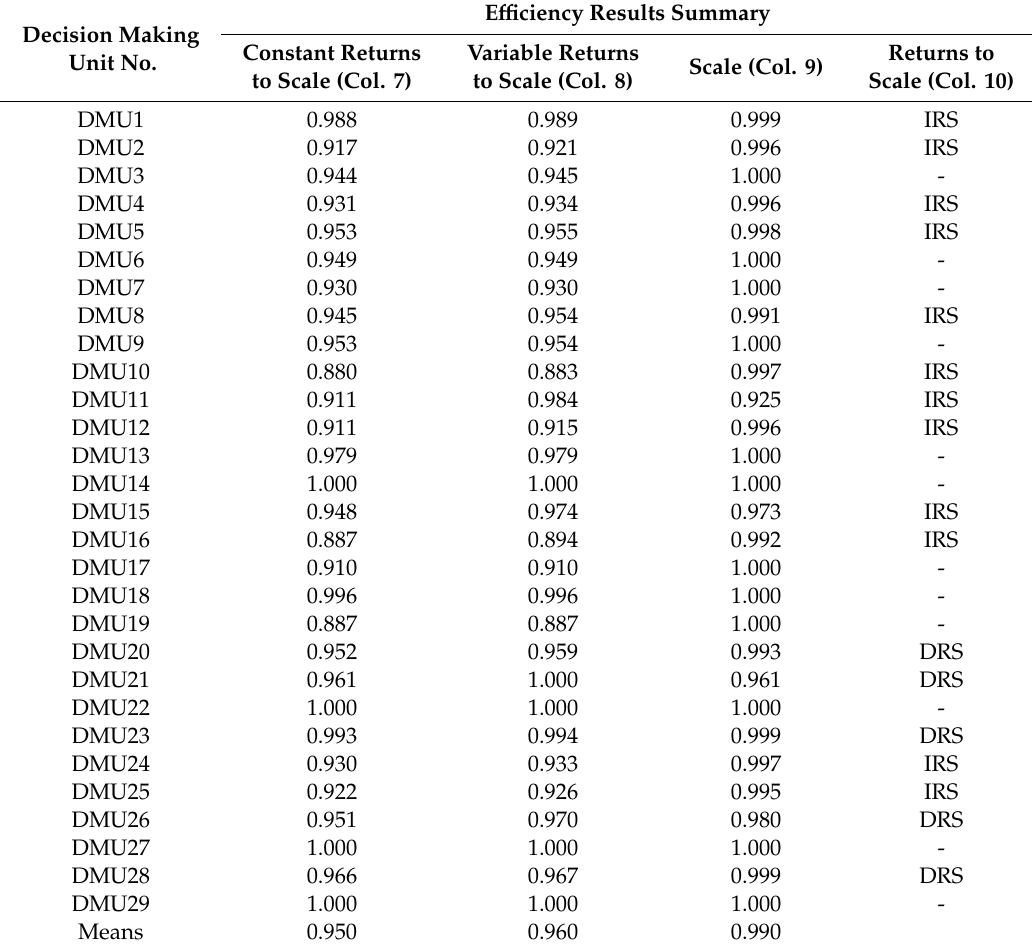
Table 3. E ffi ciency